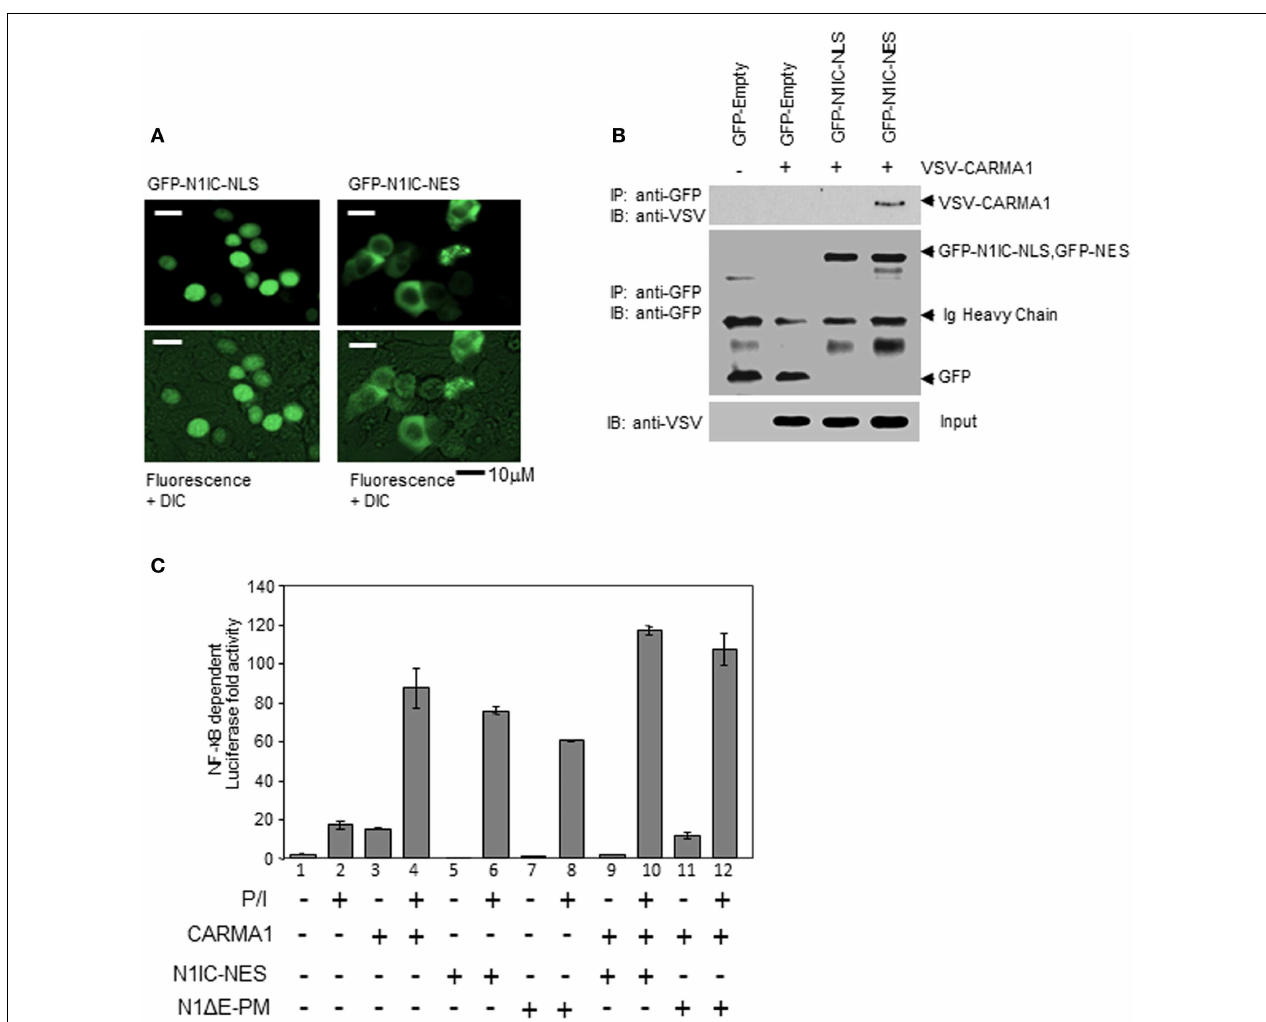
anti-GFP. 1/100 of input (shown) was immunoblotted with anti-VSV and anti-GFP. (C) Vectors expressing cytosolic N1IC–NES, membrane-tethered N1 ∆ E–PM, and/or cytosolic CARMA1 were co-transfected with an NF- κ B luciferase reporter construct into JurkatT cells, stimulated with PMA and CaI for 3h, then subjected to a luciferase reporter gene assay. Ig heavy chain indicates immunoglobulin heavy chain. Data are mean + SEM of at least three independent